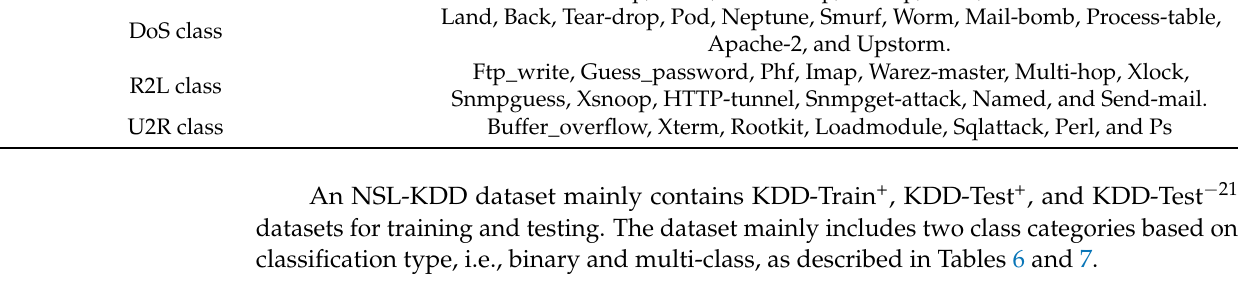
Table 6. Binary class classification (NSL-KDD) dataset.